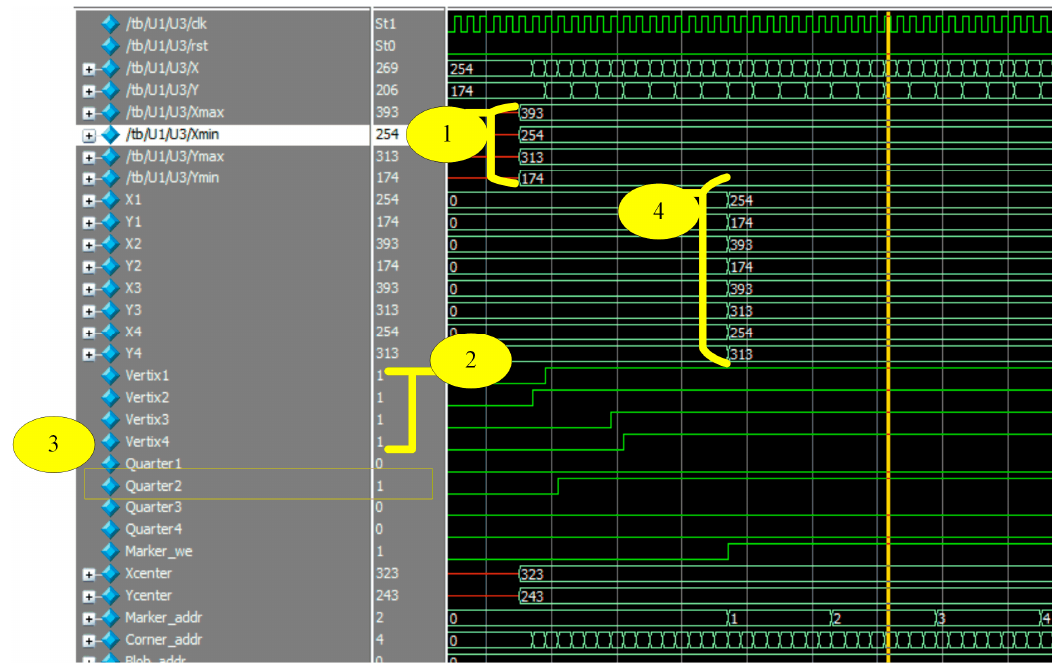
Figure 15. Matching process. . “1” illustrates reading out the coordinates of the bounding box. “2”